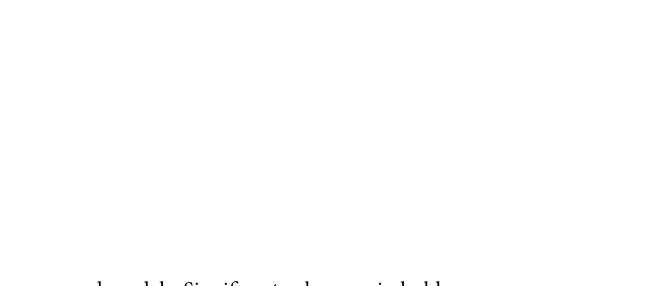
Table 5. AOC values for the REC of the proposed models. Significant values are in